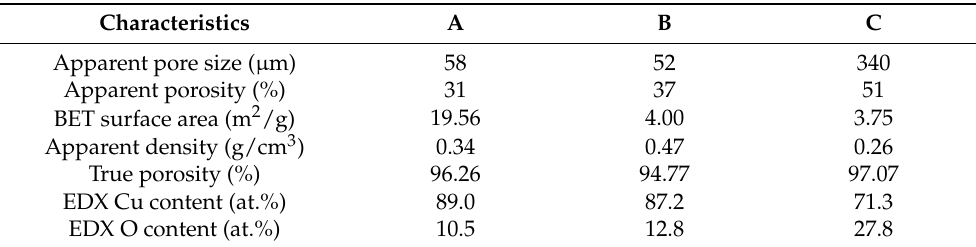
Table 2. Characteristics and properties of the porous Cu electrodes from groups A, B, and C, electrodeposited with 3 A/cm 2 for 40